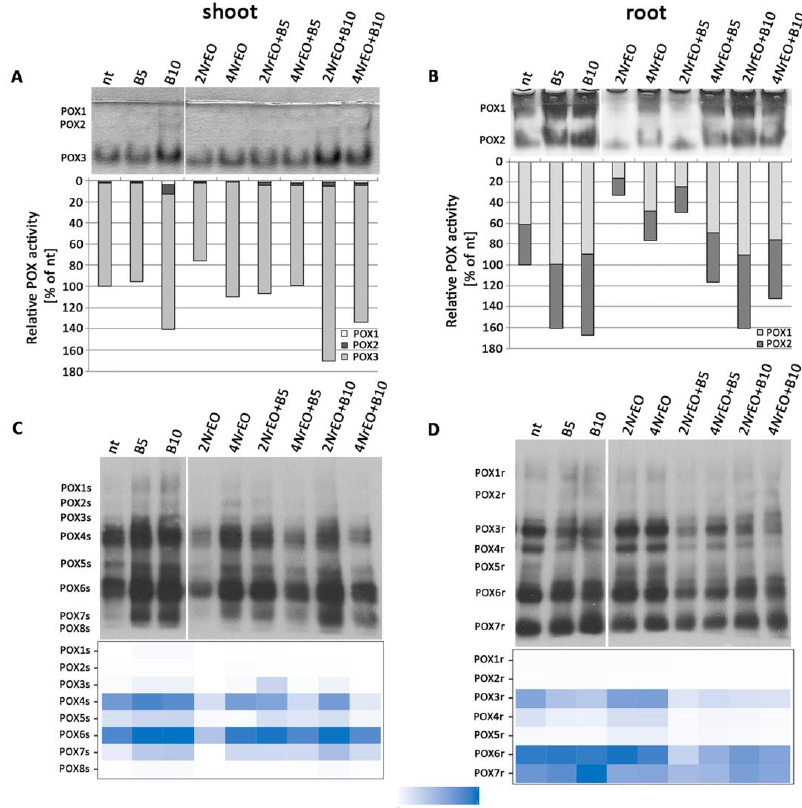
Figure 5. Peroxidases (POX) activity in Arabidopsis grown in vitro , measured 10 days after treatment with BASTA applied at two concentrations B5 (5 mg L − 1 ) and B10 (10 mg L − 1 ), N. rtanjensis essential oil applied at two concentrations 2% (2 Nr EO) and 4% (4 Nr EO), and of their combinations. Total soluble proteins were extracted from shoots and roots and loaded (20 µ g per lane) on 10% gel, separated by native-PAGE and assayed for POX activity. ( A , B ) The detected activities were measured densitometrically and presented as relative POX activity (% of control) in comparison to non-treated plants (nt). ( C , D ) For SDS-PAGE 20 µ g of soluble proteins per line from shoots and roots were loaded on 10% gel, transferred to nitrocellulose membrane and immunoblotted using primary antibodies antisheep horseradish POX. Corresponding heat-maps show relative abundances of POX proteins. Maximal values on the colour scales represent maximal values recorded for each immunoblot, independently. Abbreviations: s — shoot, r — root.